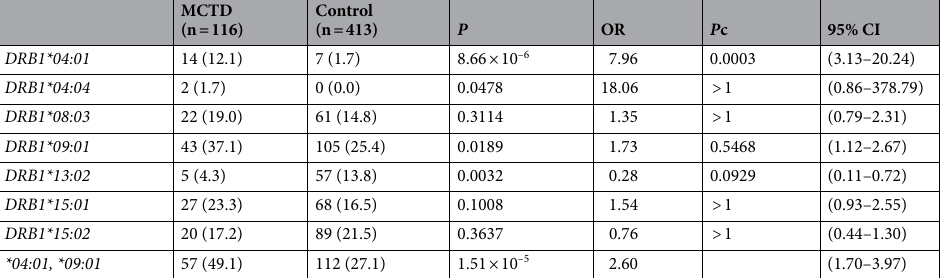
Table 1. HLA-DRB1 allele carrier frequencies in MCTD patients and controls. Allele carrier frequencies are shown in parentheses (%). Association was tested by Fisher’s exact test, using 2 × 2 contingency tables. Allele carrier frequency is the frequency of individuals with a specific allele in some populations. MCTD: mixed connective tissue disease; OR: odds ratio; CI: confidence interval; P c: corrected P ( Pc values greater than 1 are shown as “ >